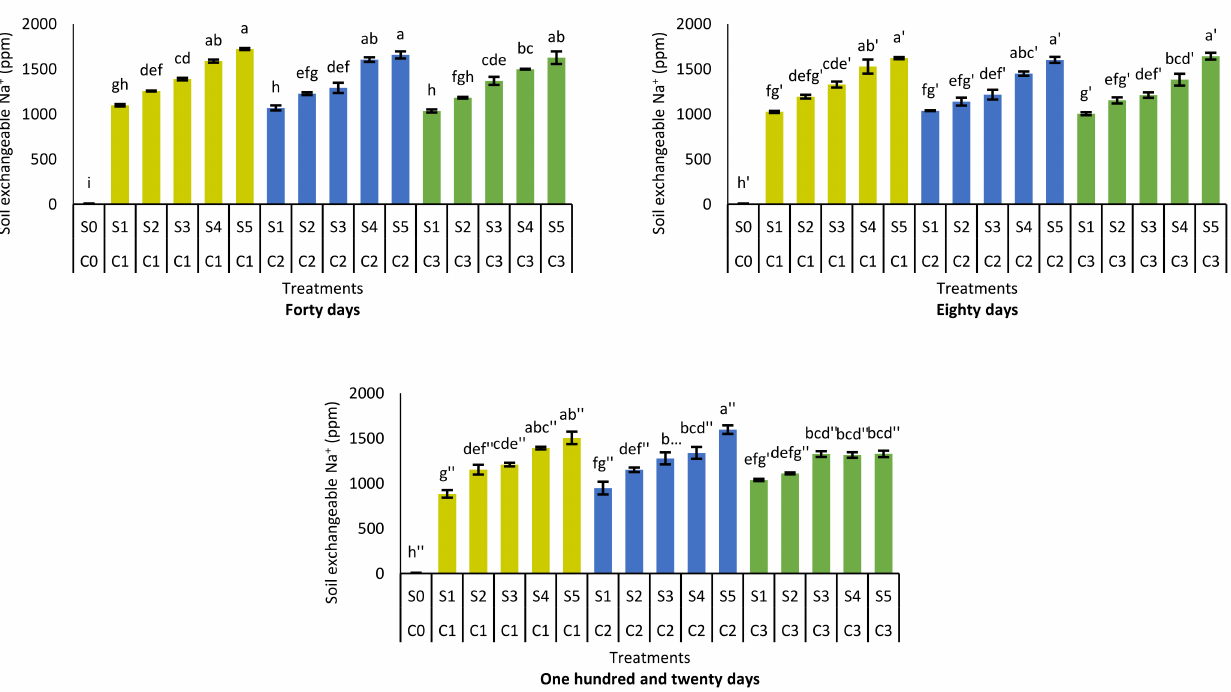
Figure 4. Soil exchangeable sodium in relation to combined use of Calciprill and sodium silicate at forty, eighty, and one hundred and twenty days incubation. Different letters indicate significant mean differences using Tukey’s HSD test at p ≤ 0.05. The error bars refer to ± standard error of three replicates. Small letters, small letters with ’, and small letters with ” indicate mean comparison at forty, eighty, and one hundred and twenty days incubation,